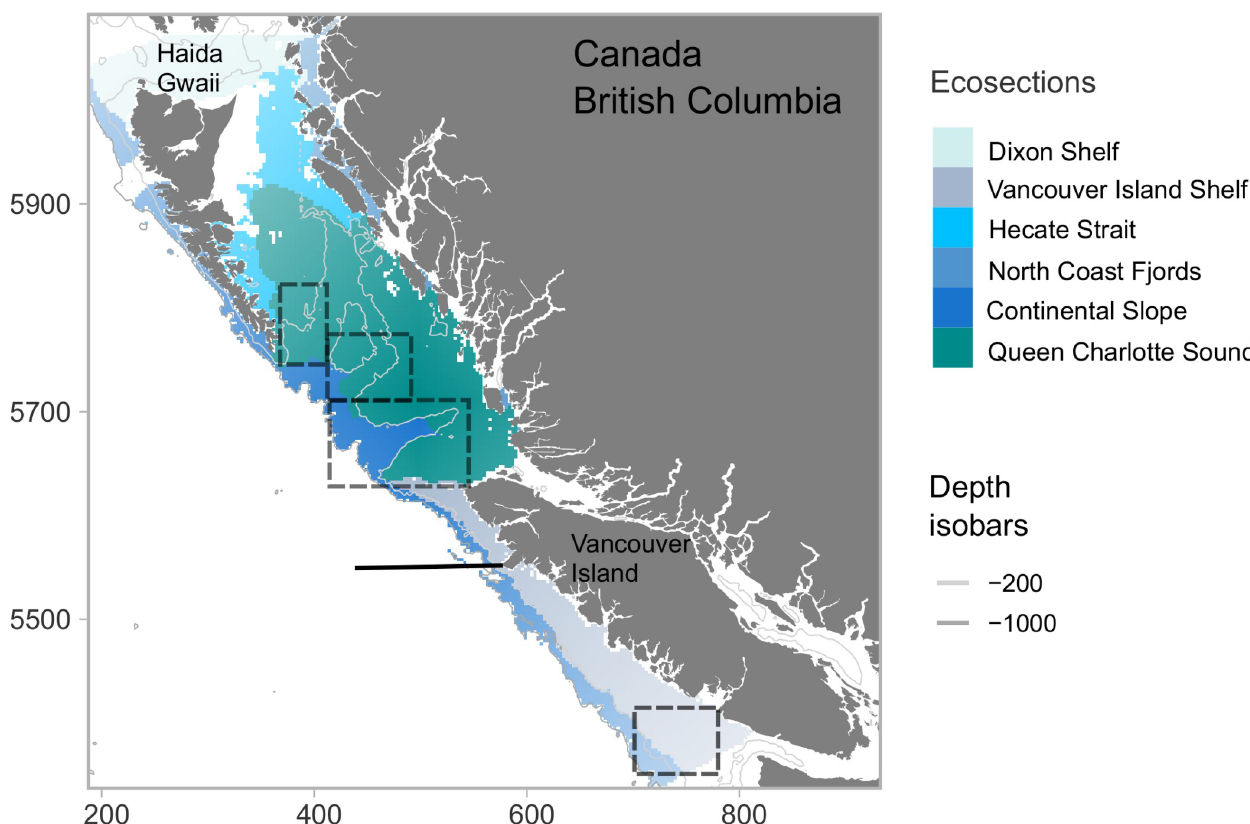
Fig 1. The area of the British Columbian shelf and slope considered in this study. Coloured sections show the boundaries of the BCMEC oceanographic ecosections. Grey lines indicate the 200 and 1000 m isobars. The solid black line shows the division of north and south bioregion sections [38]. The dashed black lines indicate regions of more complex bathymetry including the Juan de Fuca canyon and Eddy system on the Vancouver Island shelf and three sea valley and canyons systems on the west edge of Queen Charlotte Sound.